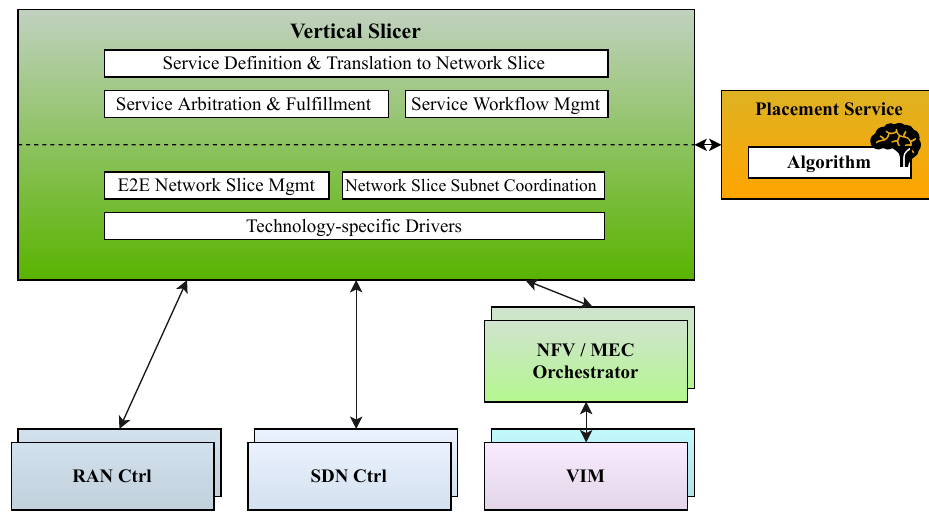
Figure 4. Orchestration Framework high-level